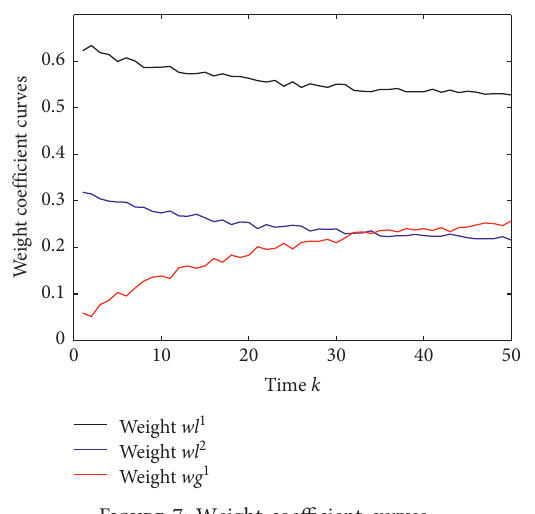
Figure 7: Weight coefficient curves. Table 1: Comparison of estimation errors and time consumption.